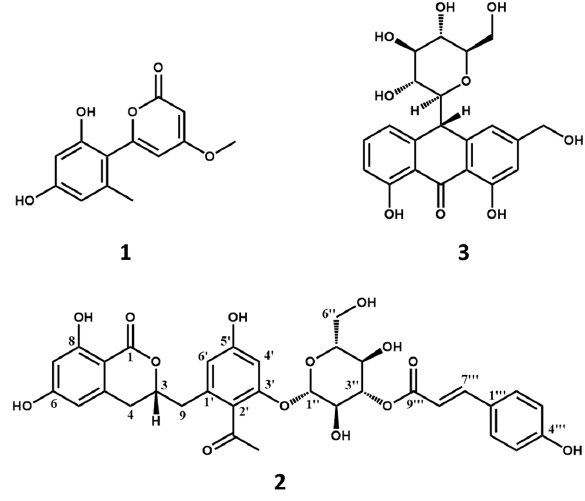
Figure 4. Chemical structures of compounds 1 , 2 , and 3 . Compound 2 was obtained as a brownish amorphous powder. Its molecular weight was determined by HRESIMS as 652 ( m / z 651.1793 (M − H) − , calc. as C 33 H 31 O 14 , 651.1714; m / z 675.1681 (M + Na) + , calc. as C 33 H 32 O 14 Na, 675.1690) with an unsaturation degree of 18 (Figures S5–S7). In the 1 H-NMR (Figure S8) spectrum of 2 (Table 1), the AABB coupling system of δ H 7.43 (2H, d, J = 8.6 Hz, H-2 ‴ , 6 ‴ ) and δ H 6.76 (2H, d, J = 8.6 Hz, H-3 ‴ , 5 ‴ ) was characteristic of a 1,4-disubstituted benzene group. The four aromatic protons at δ H 6.47 (1H, d, J = 2.0 Hz, H-6 ′ ), δ H 6.63 (1H, d, J = 2.0 Hz, H-4 ′ ), δ H 6.16 (1H, m, H-5), and δ H 6.17 (1H, m, H-7) indicated the presence of two tetrasubstituted benzene rings. In addition, one methoxy group at δ H 2.45 (3H, s, 4 ′ –COCH 3 ) and two olefinic protons at δ H 7.62 (1H, d, J = 15.9 Hz, H-7 ‴ ) and δ H 6.31 (1H, d, J = 15.9 Hz, H-8 ′′′ ) were observed. The 13 C-NMR (Figure S9) and the DEPT (Figures S10 and S11) spectra of 2 (Table 1) showed 33 carbon signals attributed to one methyl, three sp 3 methylene, sixteen methine (ten olefinic and six aliphatic), and thirteen quaternary carbons (three carbonyls, ten sp 2 including five oxygenated). The NMR signals of δ C 61.0 (C-6 (cid:48)(cid:48) ), δ C 73.2 (C-3 (cid:48)(cid:48) ), δ C 74.8 (C-2 (cid:48)(cid:48) ), δ C 77.1 J = 8.0 Hz, H-1 (cid:48)(cid:48) ) suggested the presence of a β -d-glucopyranoside. Table 1. 1 H-NMR (600 MHz) and 13 C-NMR (150 MHz) data of 2 ( δ in ppm, J in Hz, methanol- d 4